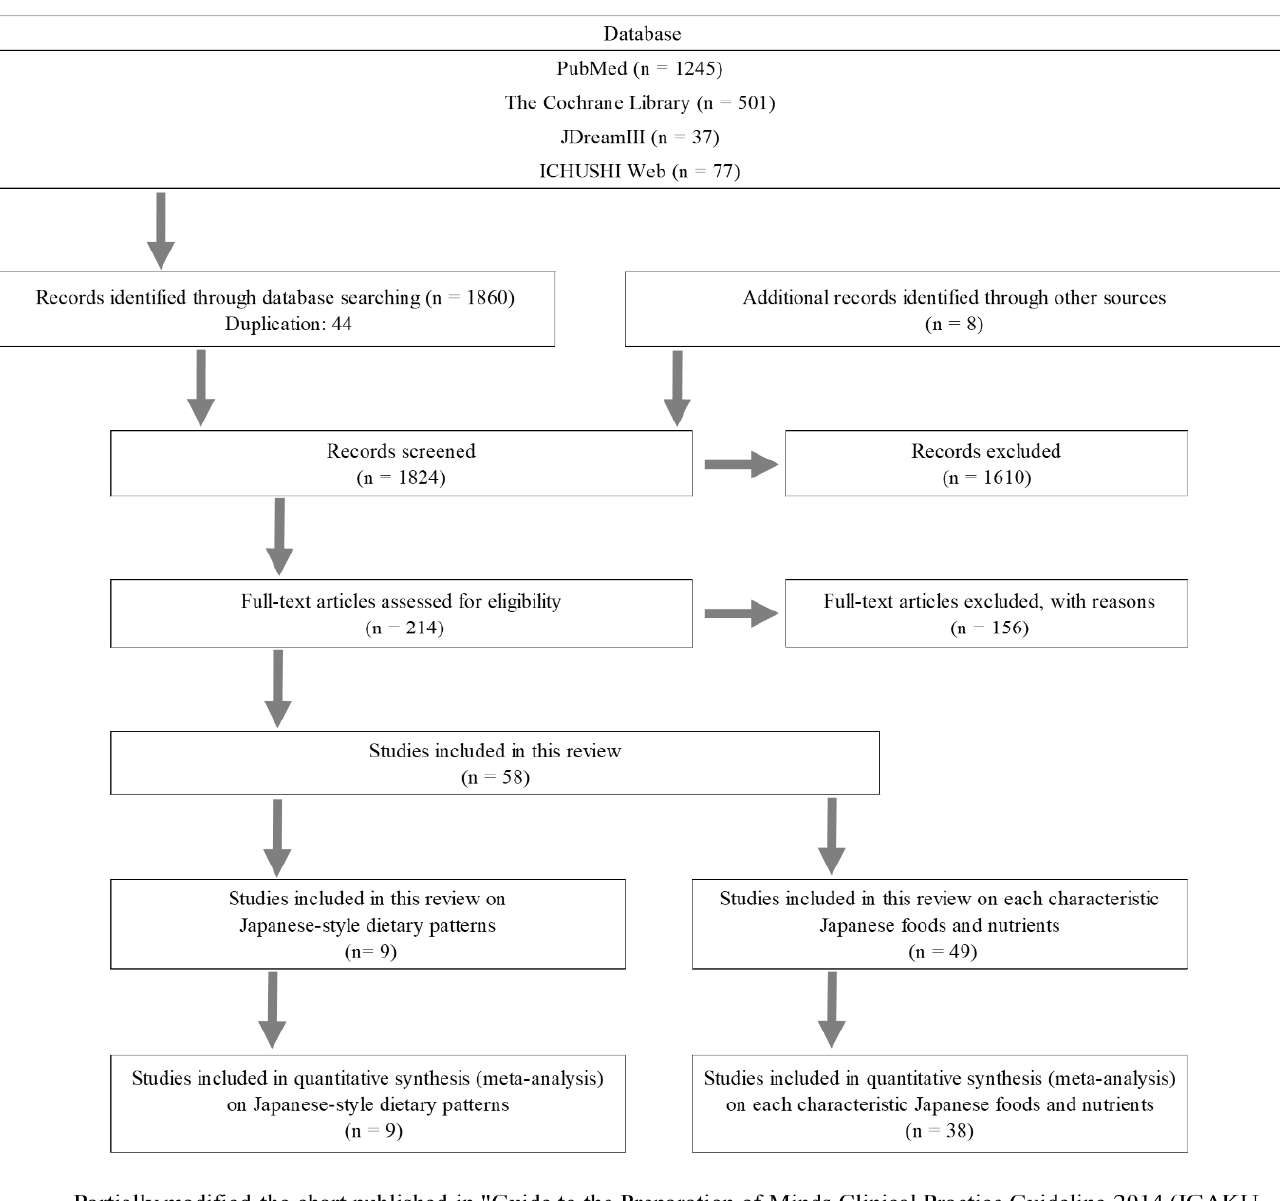
Figure 1. Flowchart of article search and study selection: PubMed (https://pubmed.ncbi.nlm.nih. gov/ (accessed on 27 July 2020)), The Cochrane Library (https://www.cochranelibrary.com/ (ac- cessed on 27 July 2020)), JDreamIII (https://jdream3.com/ (accessed on 27 July 2020)) and ICHUSHI Web (https://search.jamas.or.jp/ (accessed on 27 July 2020)).